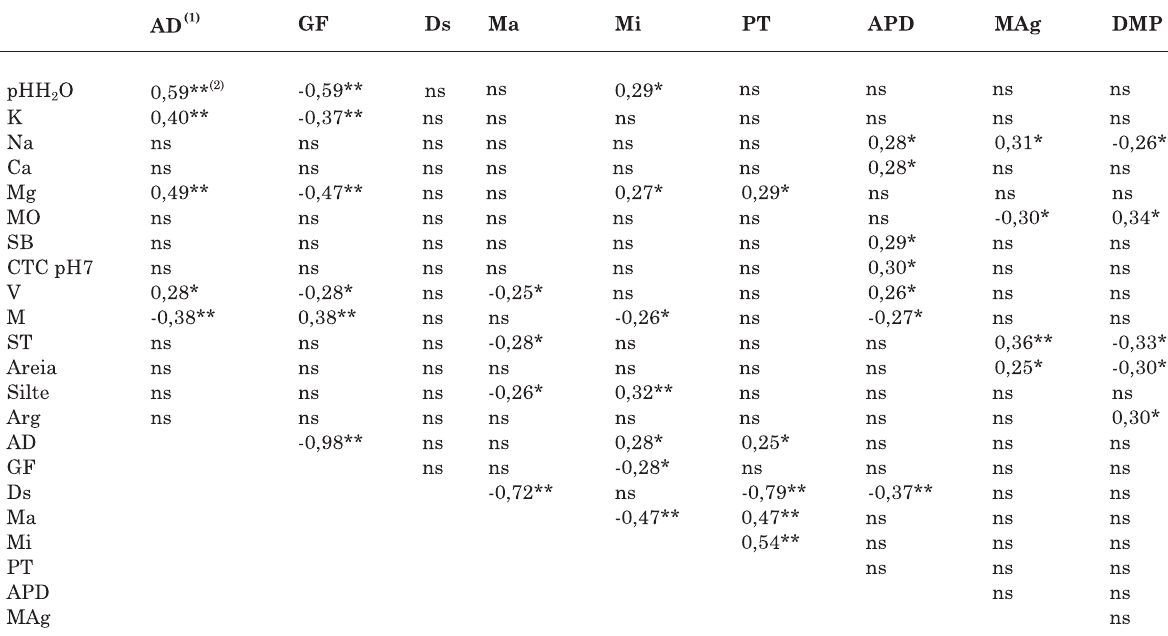
Quadro 4. Correlações de Pearson entre as propriedades físicas e químicas do solo reconstruído